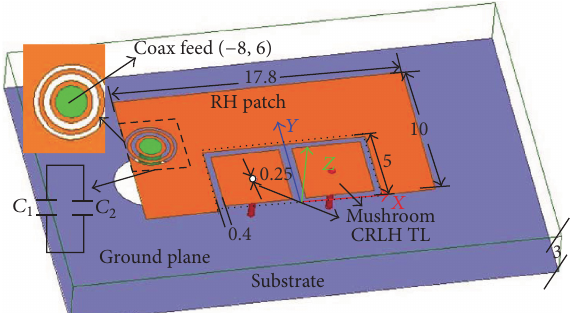
Figure 4: Perspective view of the proposed dual-band antenna with geometrical parameters (in mm).